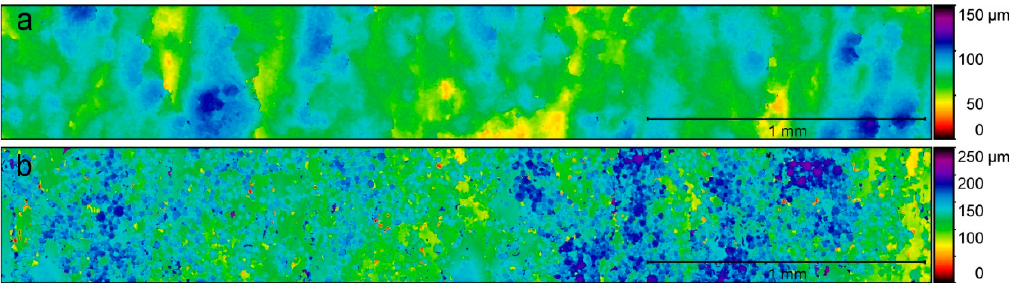
Figure 3. Surface topography in a false-color gradient of the small-diameter specimens fabricated with ( a ) new powder and ( b ) recycled powder.